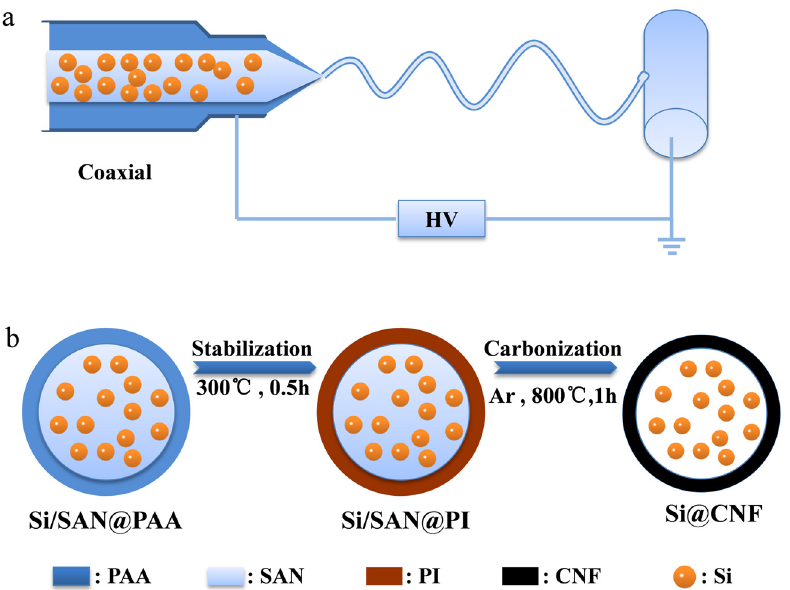
Figure 1: ( a ) Schematic of dual nozzle coaxial electrospinning setup and ( b ) electrospun preparation process and structure of